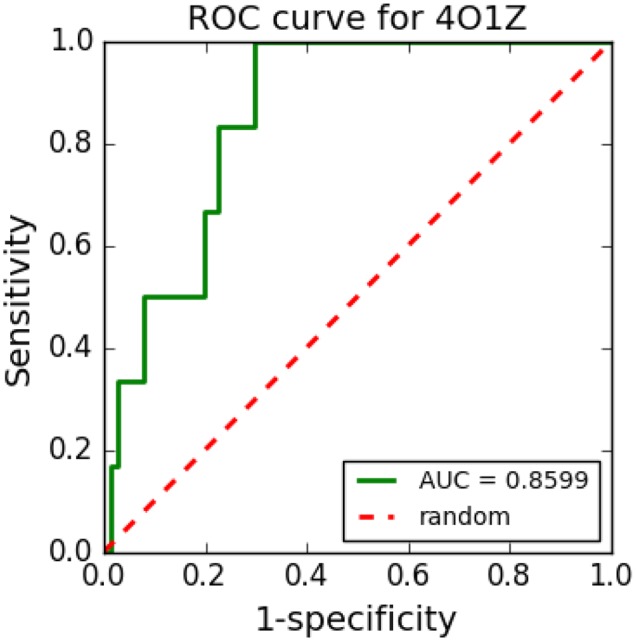
ROC curve example.